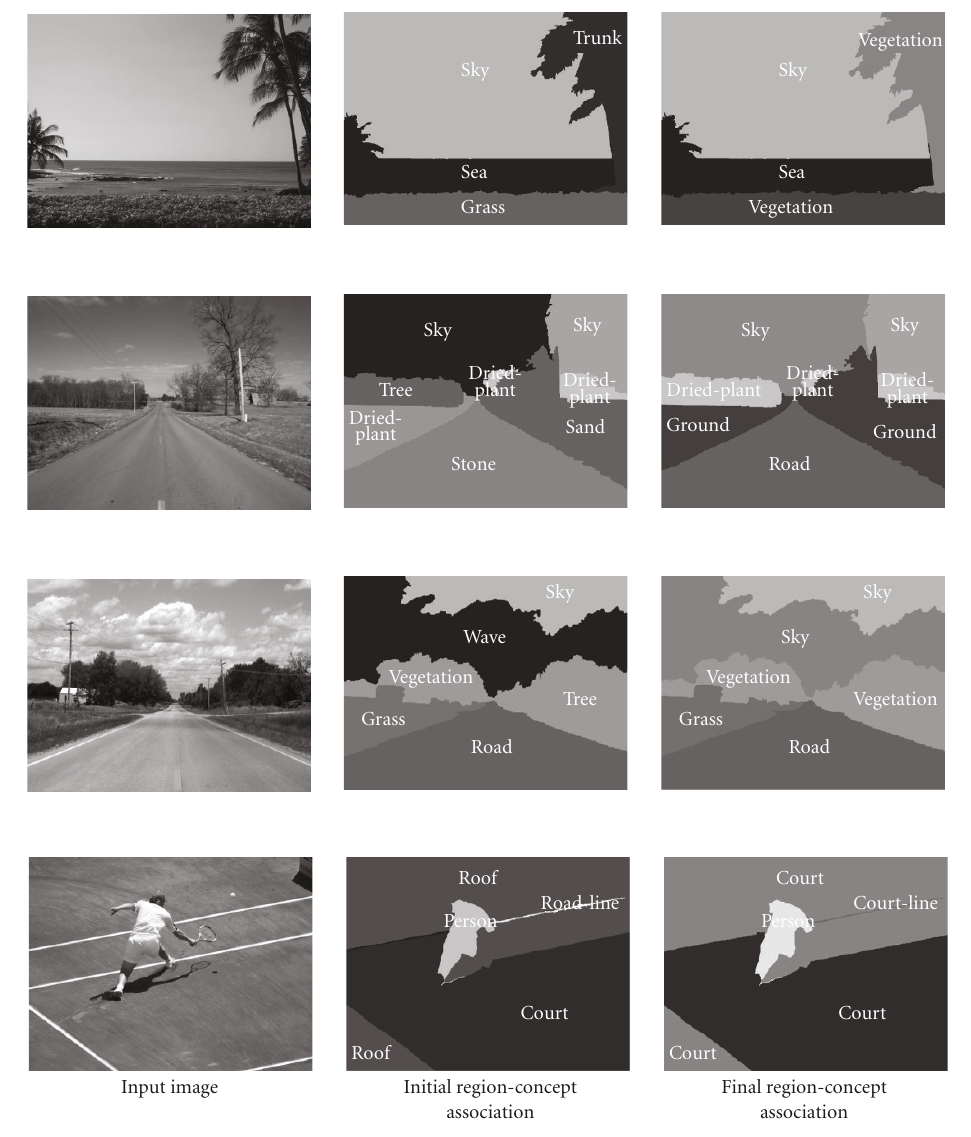
Figure 8: Indicative region-concept association results.